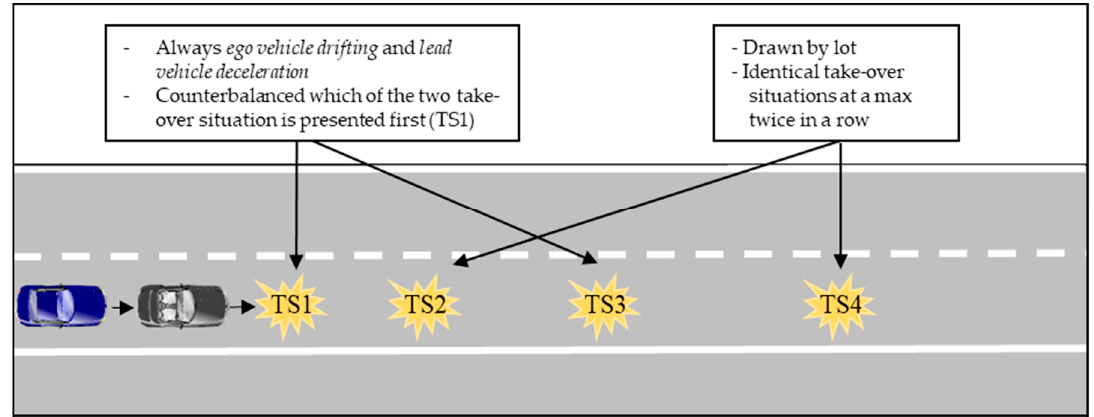
Figure 2. Overview of the four take-over situations presented to the participants per trial.